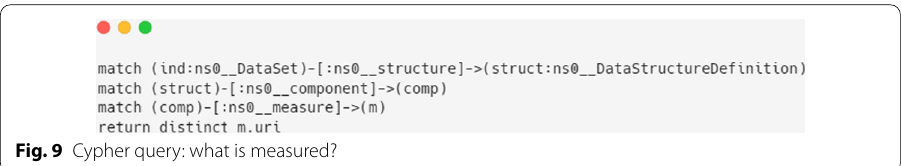
Fig. 9 Cypher query: what is measured?